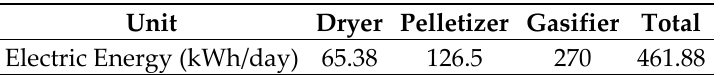
Table 3. Consumptions per day of all units of the system.